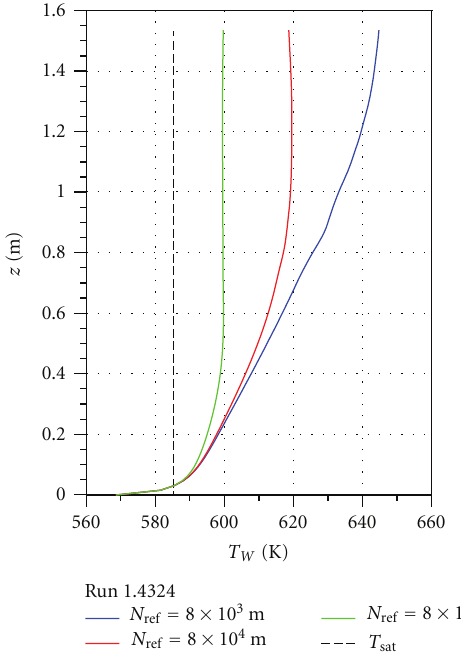
Figure 6: Cross sectionally averaged gas fraction.